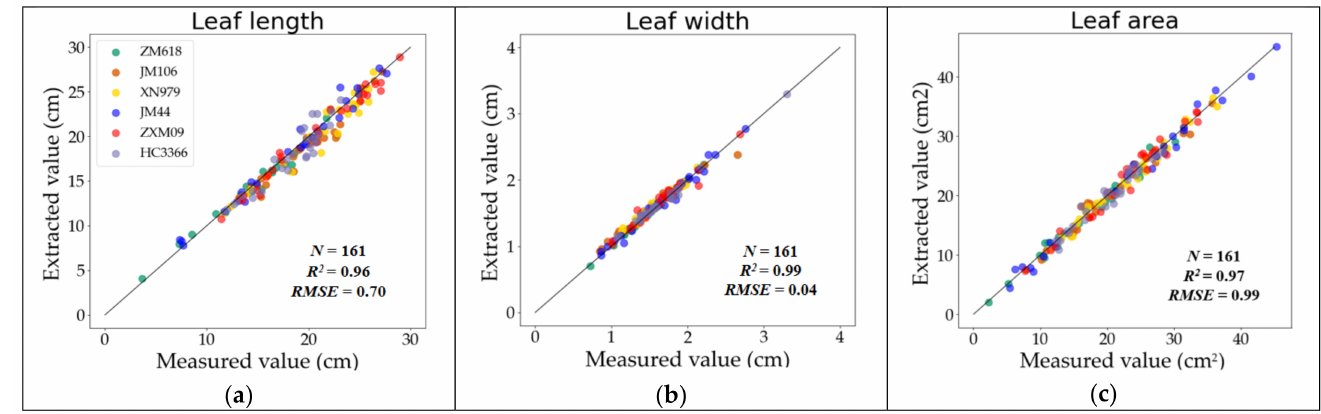
Figure 11. Comparison between extracted and measured parameters of six wheat cultivars. ( a ) Com- parative result of leaf length; ( b ) Comparative result of leaf width; ( c ) Comparative result of leaf